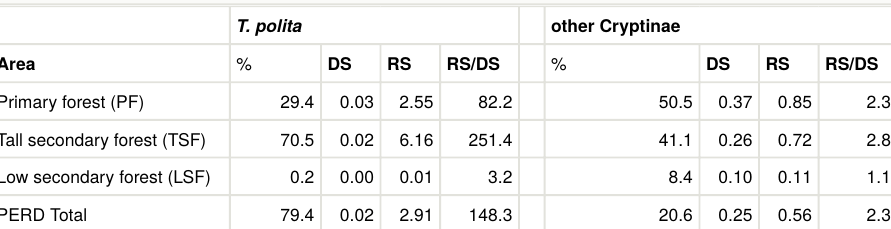
Comparison of sampling e ffi ciency during the dry season (DS) vs. rainy season (RS) in the three sampled successional areas. RS/DS , how many times larger was the sampling e ffi ciency in the rainy season in relation to the dry season. Sampling e ff ort was identical for all areas, adding to 4,113 trap-days total, but di ff erent between seasons (DS=1,836, RS=2,277). %, percentage of specimens. T. polita other Cryptinae Area %